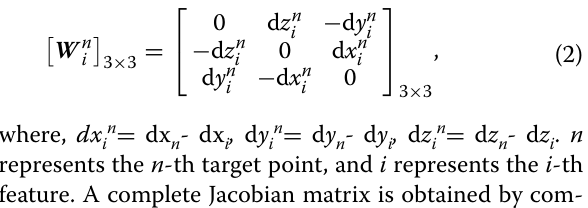
y and z axis, respectively. Similarly, the α , β and γ are the three rotation vectors around x , y and z axis, respectively. The Jacobian matrix is divided into two parts used to describe the translation and rotation motions of fea- tures, respectively. For the translation vector, the direct cumulative operation can be done for the translation of the target point and it does not affect the rotation move- ment. For the rotation vector of the feature, the effect on the translation of the target point is equal to the cross- product between the rotation vector and the translation distance (here, [ W in ] is defined to represent it) of the tar- get point, which is called leverage effect. And the effect of rotation vector on the rotation of target point can be directly accumulated. [ W in ] is a skew-symmetric matrix and can be defined as Eq.